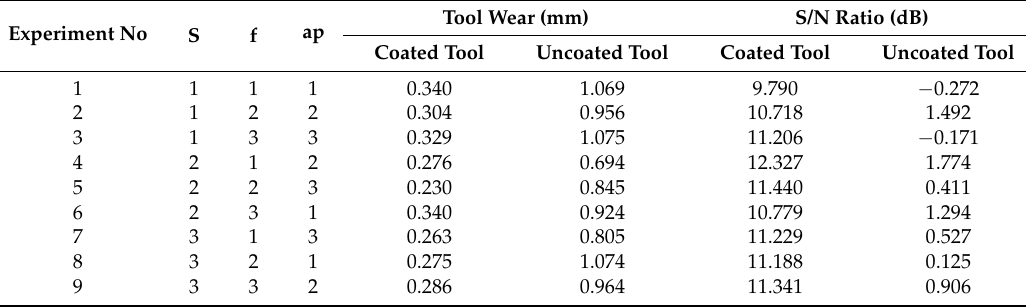
Table 7. The experimental results for tool wear and S/N ratio.